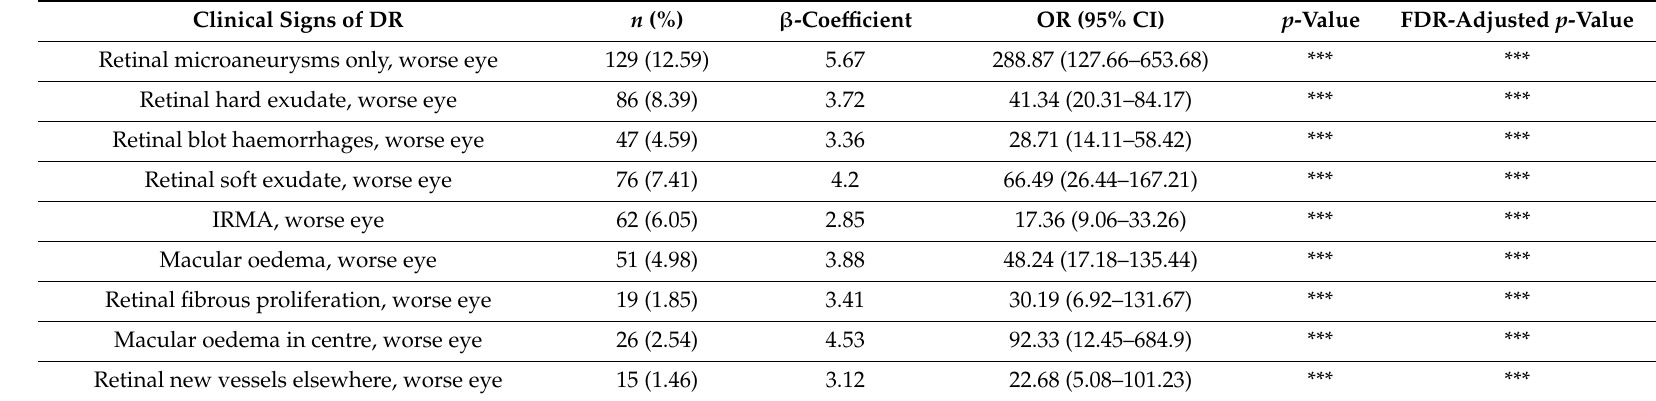
Table 2. Retinal lesions that constitute diabetic retinopathy outcome.